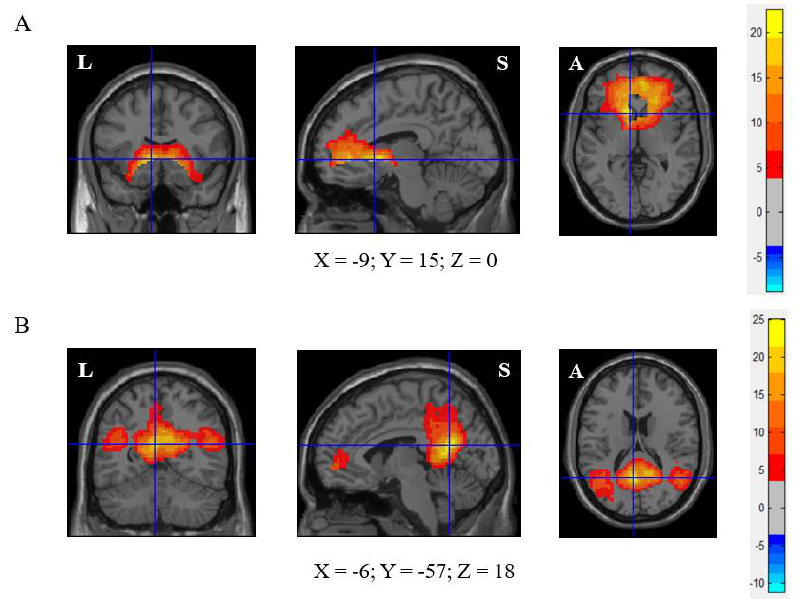
Figure 2. Olfactory network (ON) and default mode network (DMN) of this cohort. ( A ) ON (left caudate nuclei ( − 9, 15, 0) as seed), ( B ) DMN (left precuneus ( − 6, − 57, 18) as seed). FDR correction, p < 0.05, voxel size > 2700mm 3 .